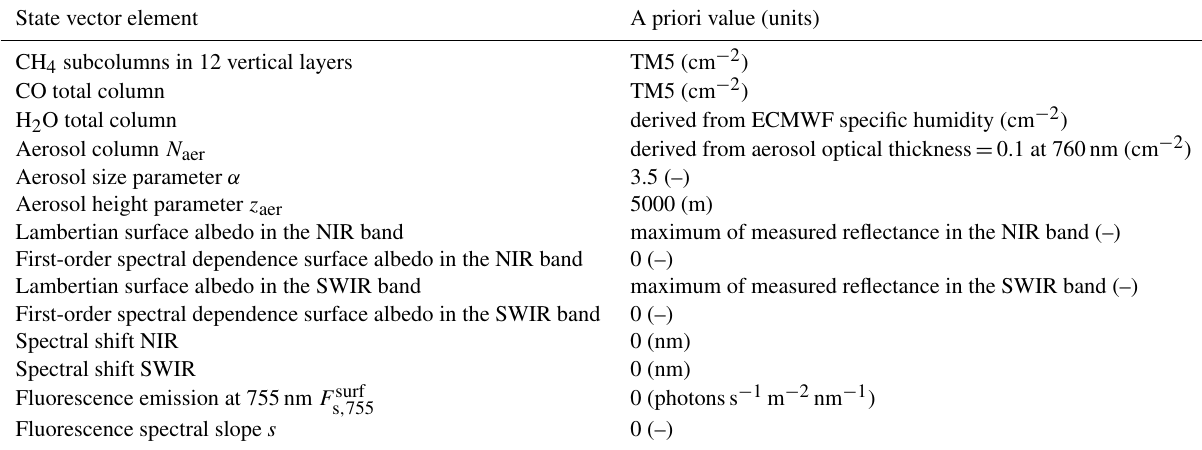
Table 1. State vector elements and their a priori values or references to source. State vector element A priori value (units)